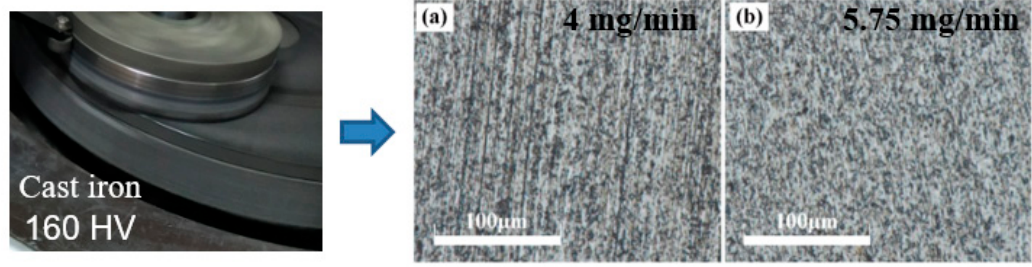
Figure 5. Optical images after lapping using cast iron pad: ( a ) common lapping; ( b ) ultrasonic-assisted lapping.